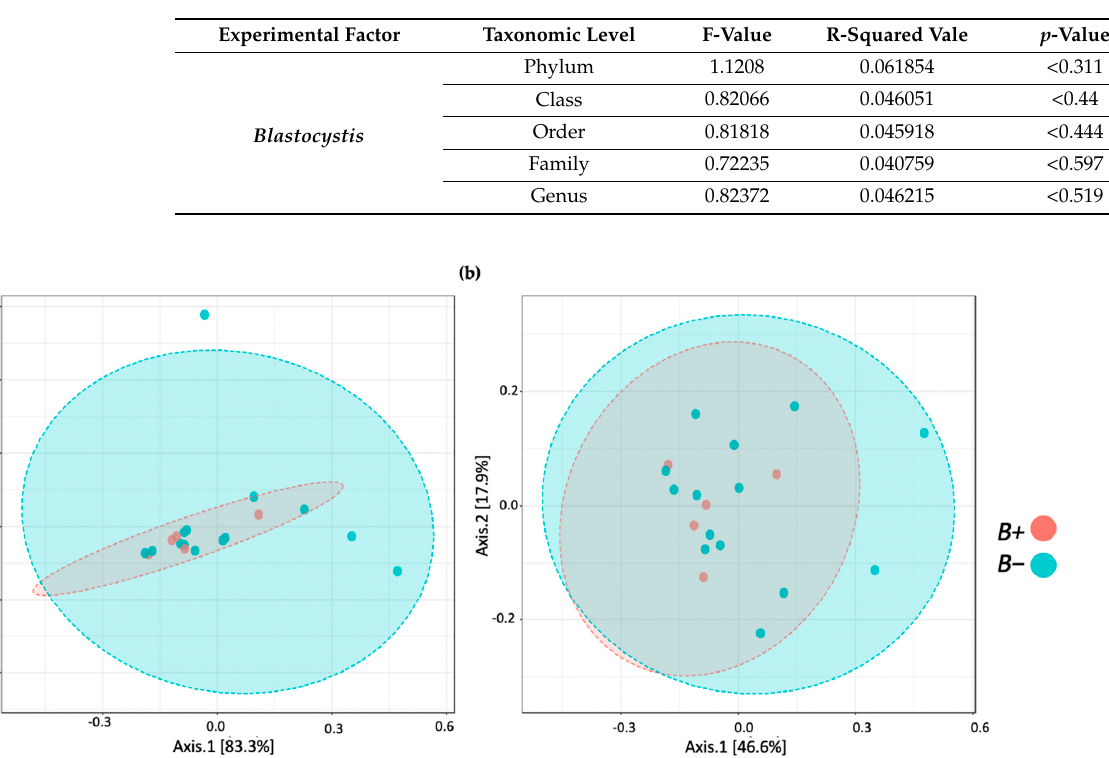
Table A6. Taxa table showing the relationships between identified OTUs via MetagenomeSeq. The observed change in OTU abundance in B + voles compared with B - voles is summarised in the ‘Result’ column. Phylum Table A4. Beta diversity results for Blastocystis positive ( B +) voles compared with negative ( B -) voles. Diversity was measured using Bray-Curtis dissimilarity index with Permutational Multivariate Analysis of Variance Using Distance Matrices (PERMANOVA). No significant results were identified ( p < 0.05).